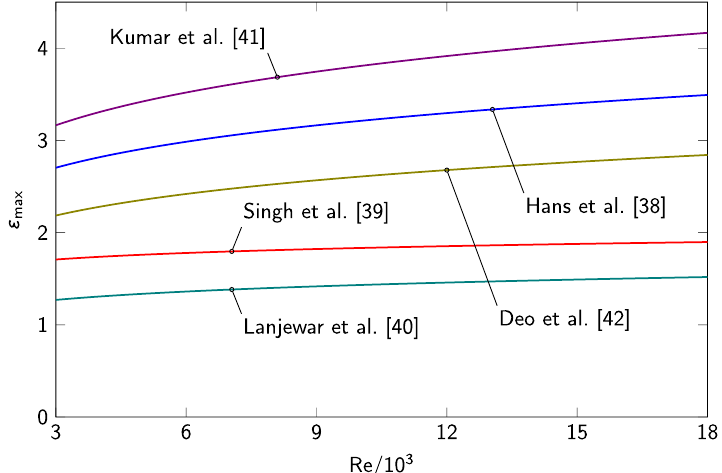
Figure 7. Relationship between η max and Re for absorber plates with straight ribs and ˙ G = 1000Wm − 2 .